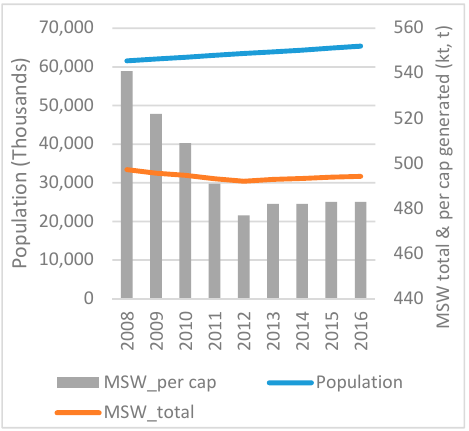
Figure 55. Population and MSW production in UK 2008–2016 (EUROSTAT 2019a, 2019c).